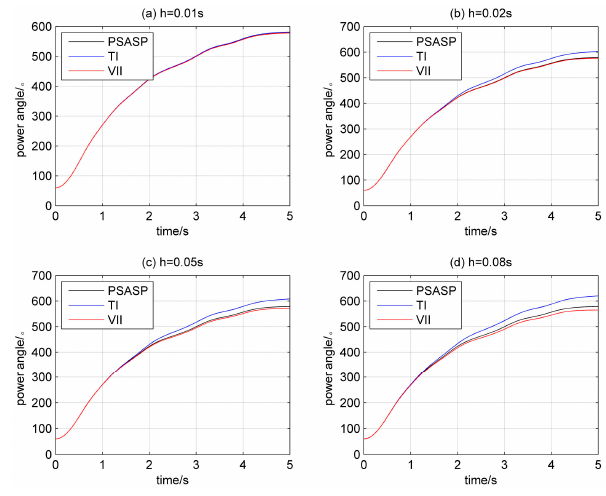
Figure 7. Power angle using different step sizes in case C.